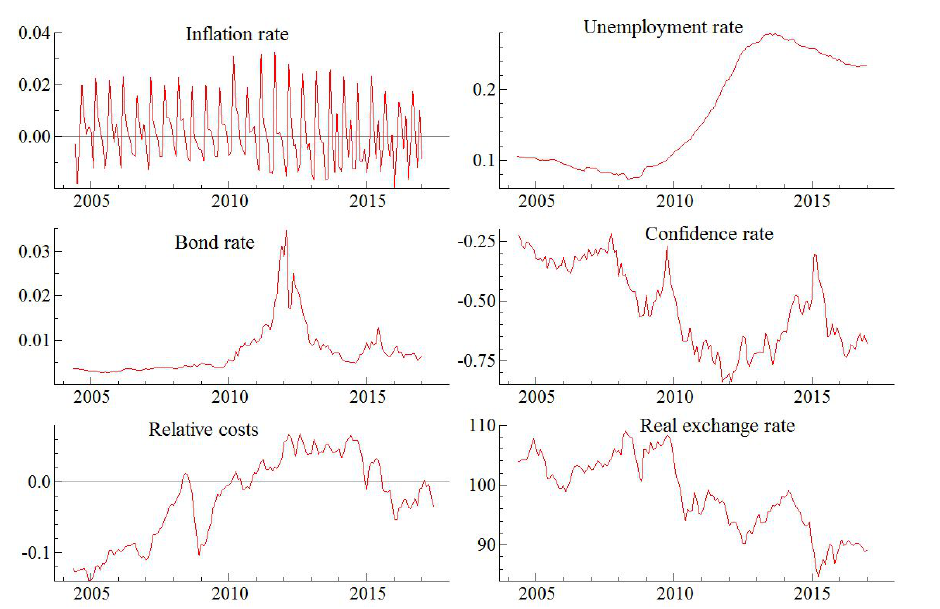
Figure 1: Graphs of the